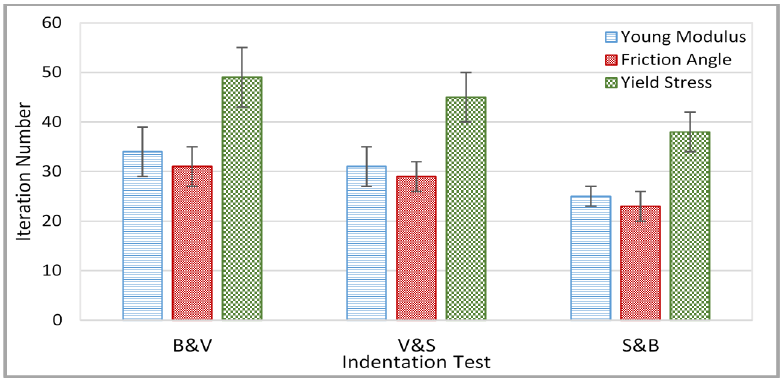
Figure 11. Optimization history of ( E , σ yc , β ) based on B&V, V&S, and S&B indentation tests.